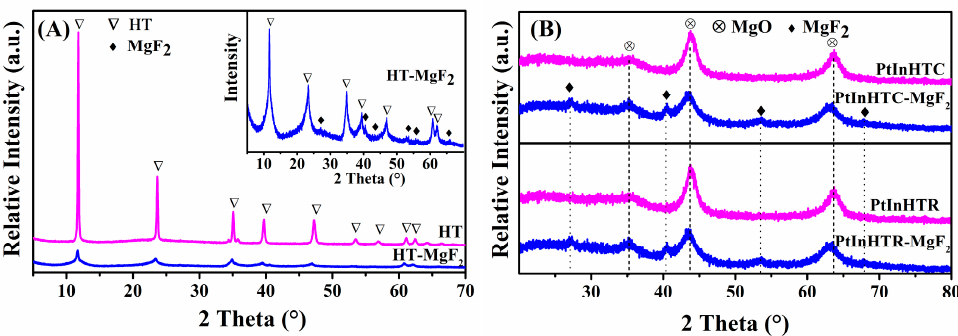
Figure 1. X-ray diffraction (XRD) patterns of ( A ) the support composites and ( B ) the calcined and reduced